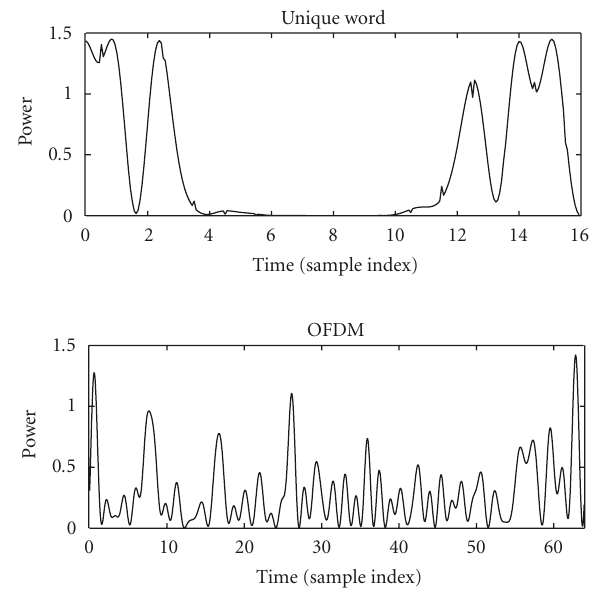
Figure 10: Time-domain waveforms for an optimized UW and an optimized OFDM training